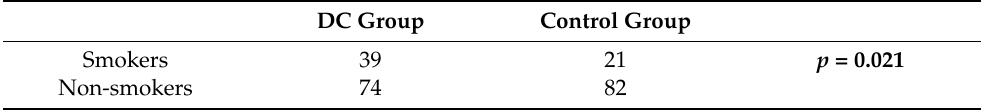
Table 5. Distribution of smokers and non-smokers between patient groups. DC Group Control Group Smokers 39 21 p = 0.021 Non-smokers 74